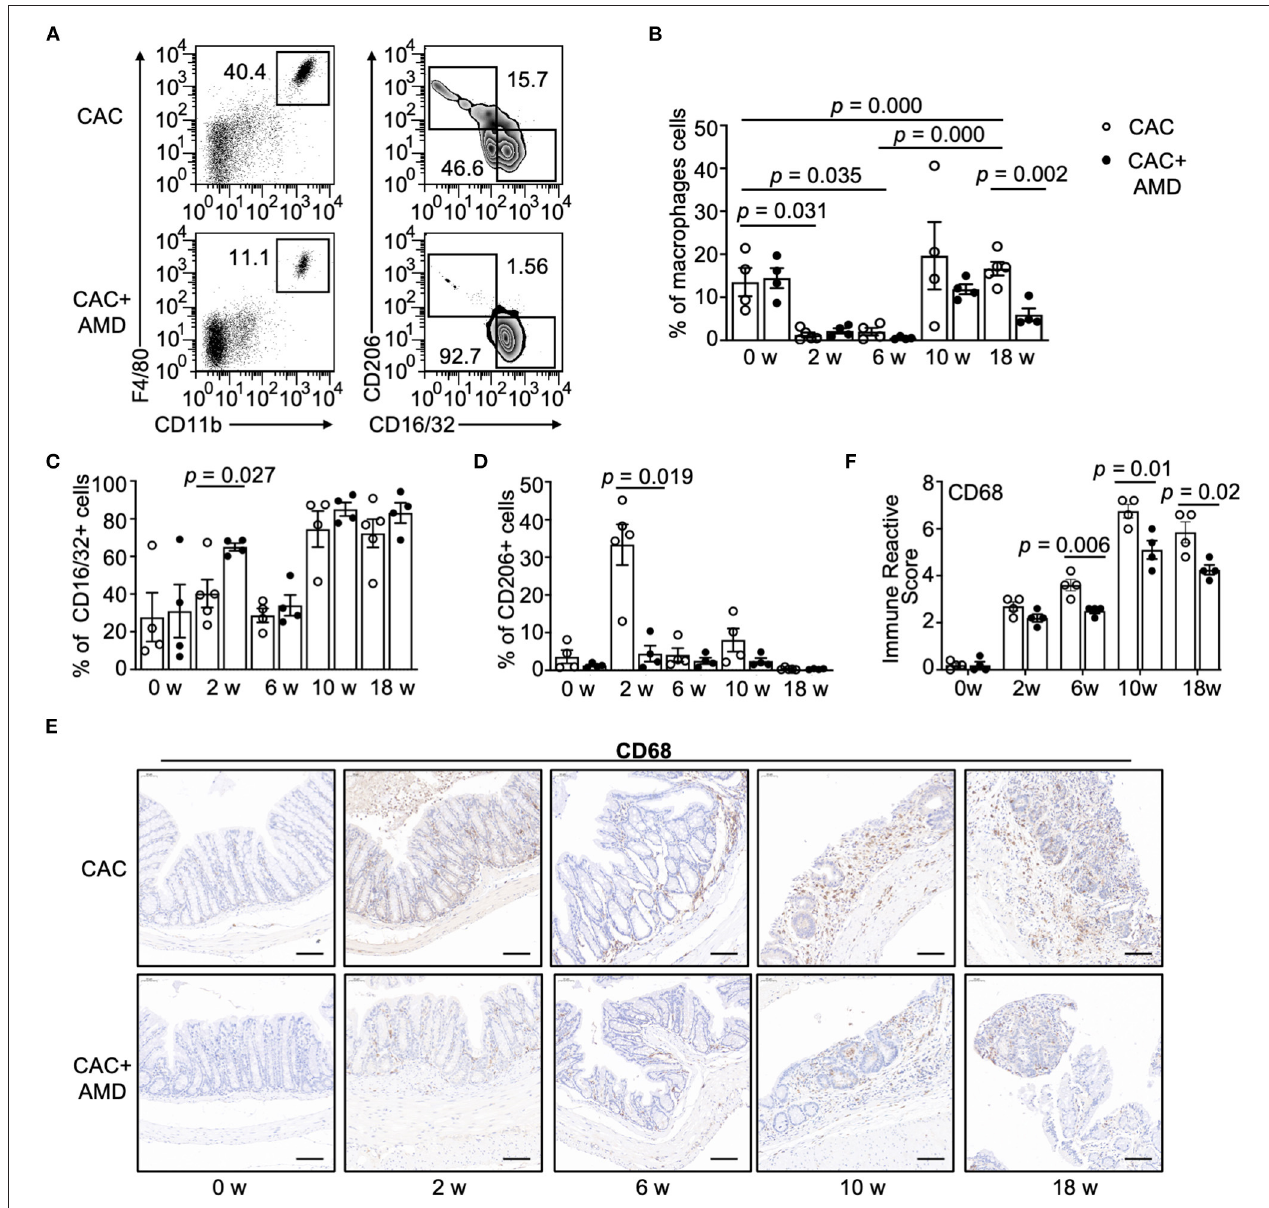
FIGURE 3 | AMD3100 inhibited PM recruiting and regulated the proportions of the M1/M2 subpopulation. (A) Flow cytometric characterization of macrophages in representative samples of peritoneal lavage cells in mice from the 10 th week post-AOM/DSS induction. Cells were identified as follows: macrophages = CD11b + F4/80 + , M1 = CD11b + F4/80 + CD16/32 + CD206 − , and M2 = CD11b + F4/80 + CD16/32 − CD206 + . (B) Percentage of macrophages in peritoneal lavage cells in two groups in untreated mice and mice from the 2 nd , 6, 10 and 18 th -weeks post-AOM/DSS induction ( n ≥ 4). (C,D) Percentage of CD16/32 + CD206 − M1 type and CD16/32 − CD206 + M2 type macrophages in peritoneal macrophages (PMs) from two groups in the 0 th , 2 nd , 6, and 18 th -weeks post-AOM/DSS induction ( n ≥ 4). (E,F) Representative images of immunohistochemical staining for CD68 in colonic mucosa in mice from each group at 0, 2, 6, 10, and 18 weeks after AOM/DSS treatment and quantified immune reactive scores (scale bar = 50 nm, magnification 200 × ). Individual data are shown as Mean ± SD. Statistical analysis was carried out using unpaired t